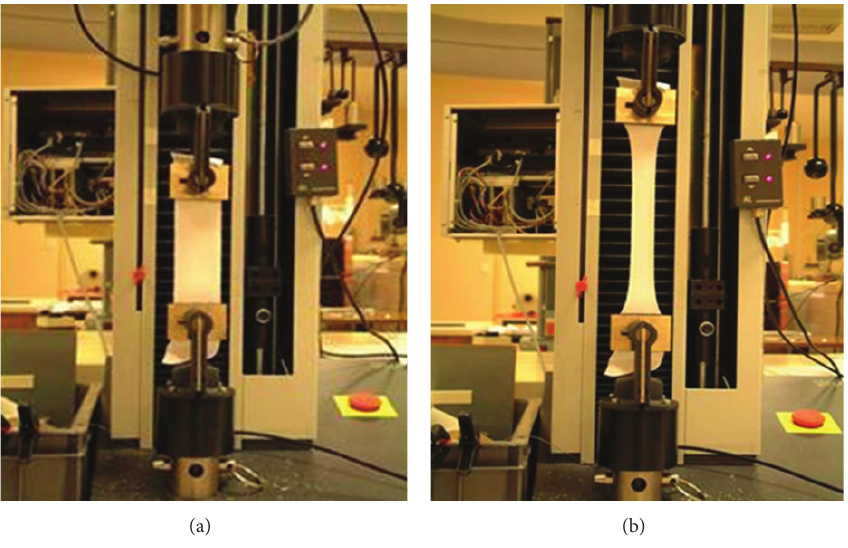
F 12: Tensile test of preimpregnated woven fabric.